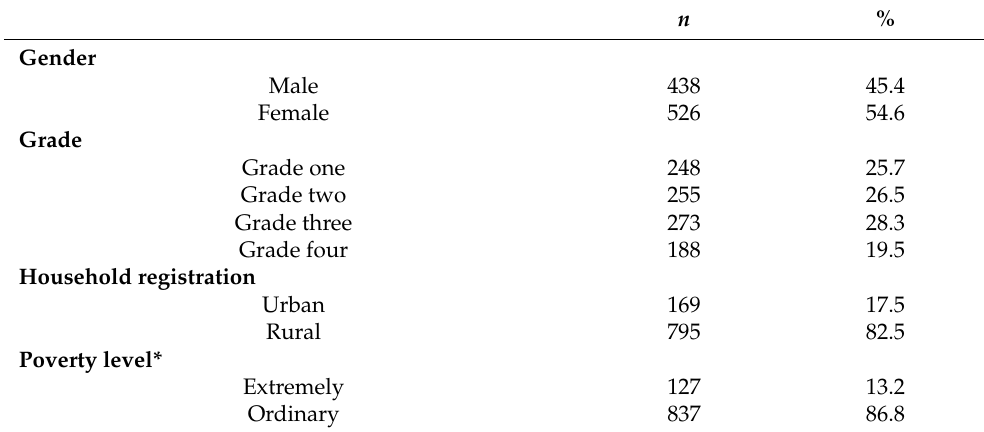
Table 1. Participants’